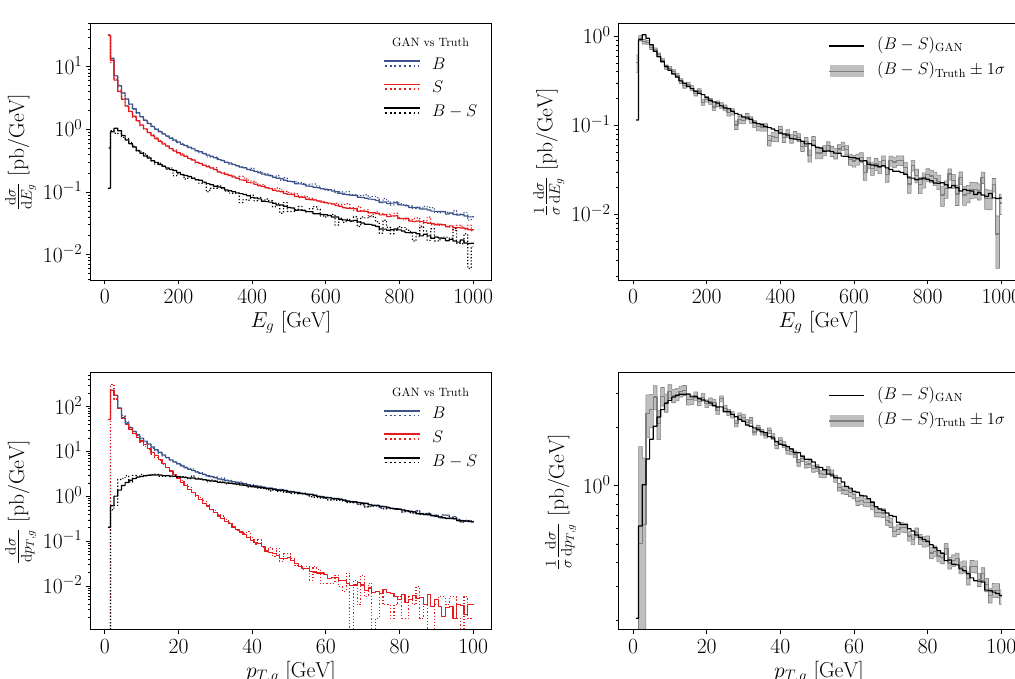
Figure 7: Left: Generated (solid) and true (dashed) Z g events at the LHC for the two input distributions and the subtracted output. Right: distribution of the subtracted events, true and generated, including the error envelope propagated from the input